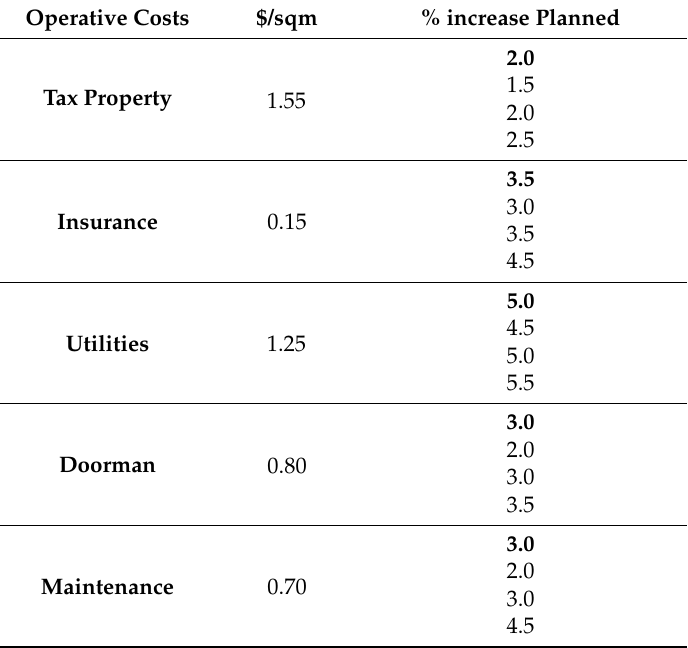
Table 4. Percentage of the fuzzy increment for each operative cost amount.